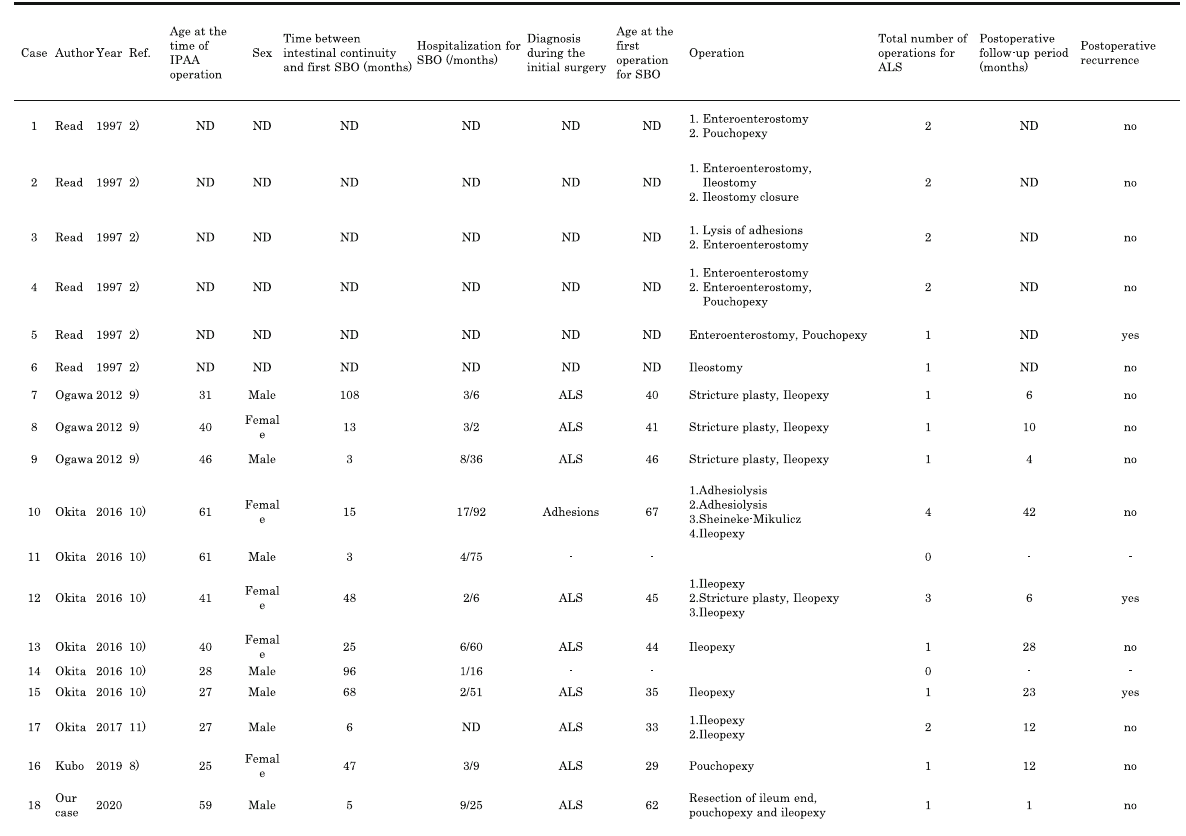
Table 1 Reported case of afferent limb after IPPA